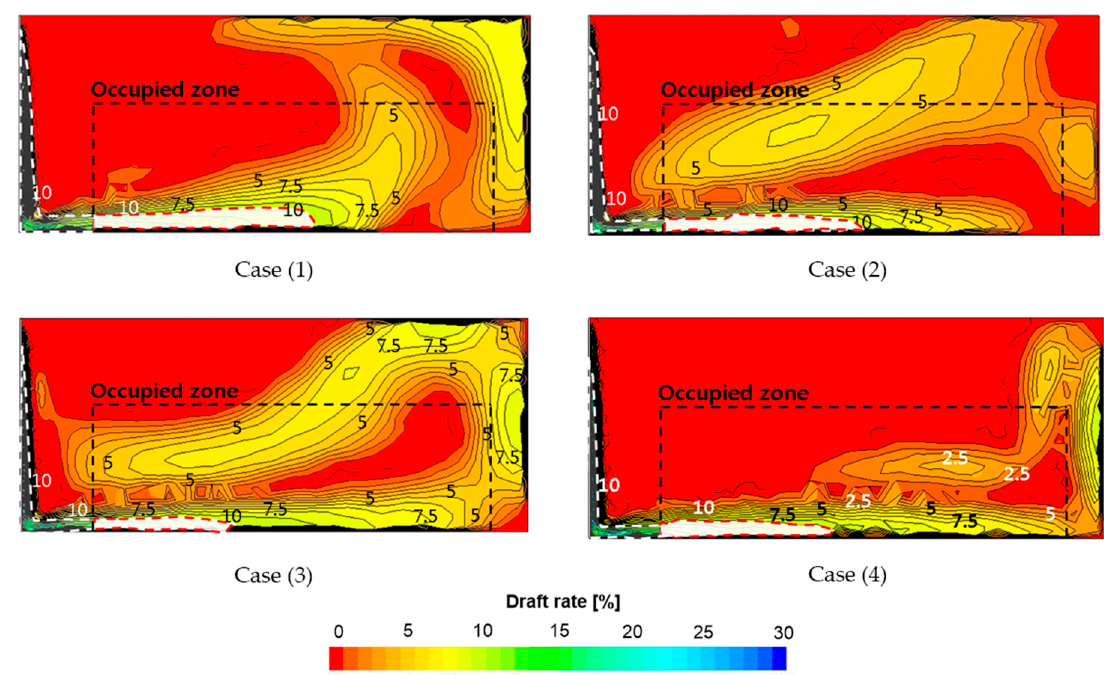
Figure 11. Draft rate distribution.